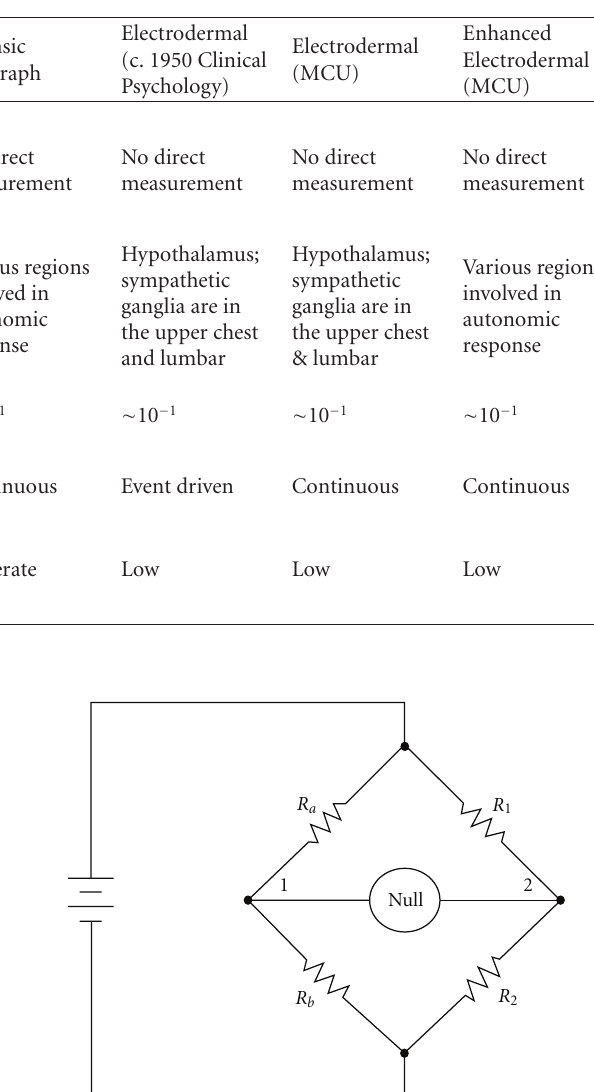
Table 1: Comparison of a ff ective data acquisition technologies.